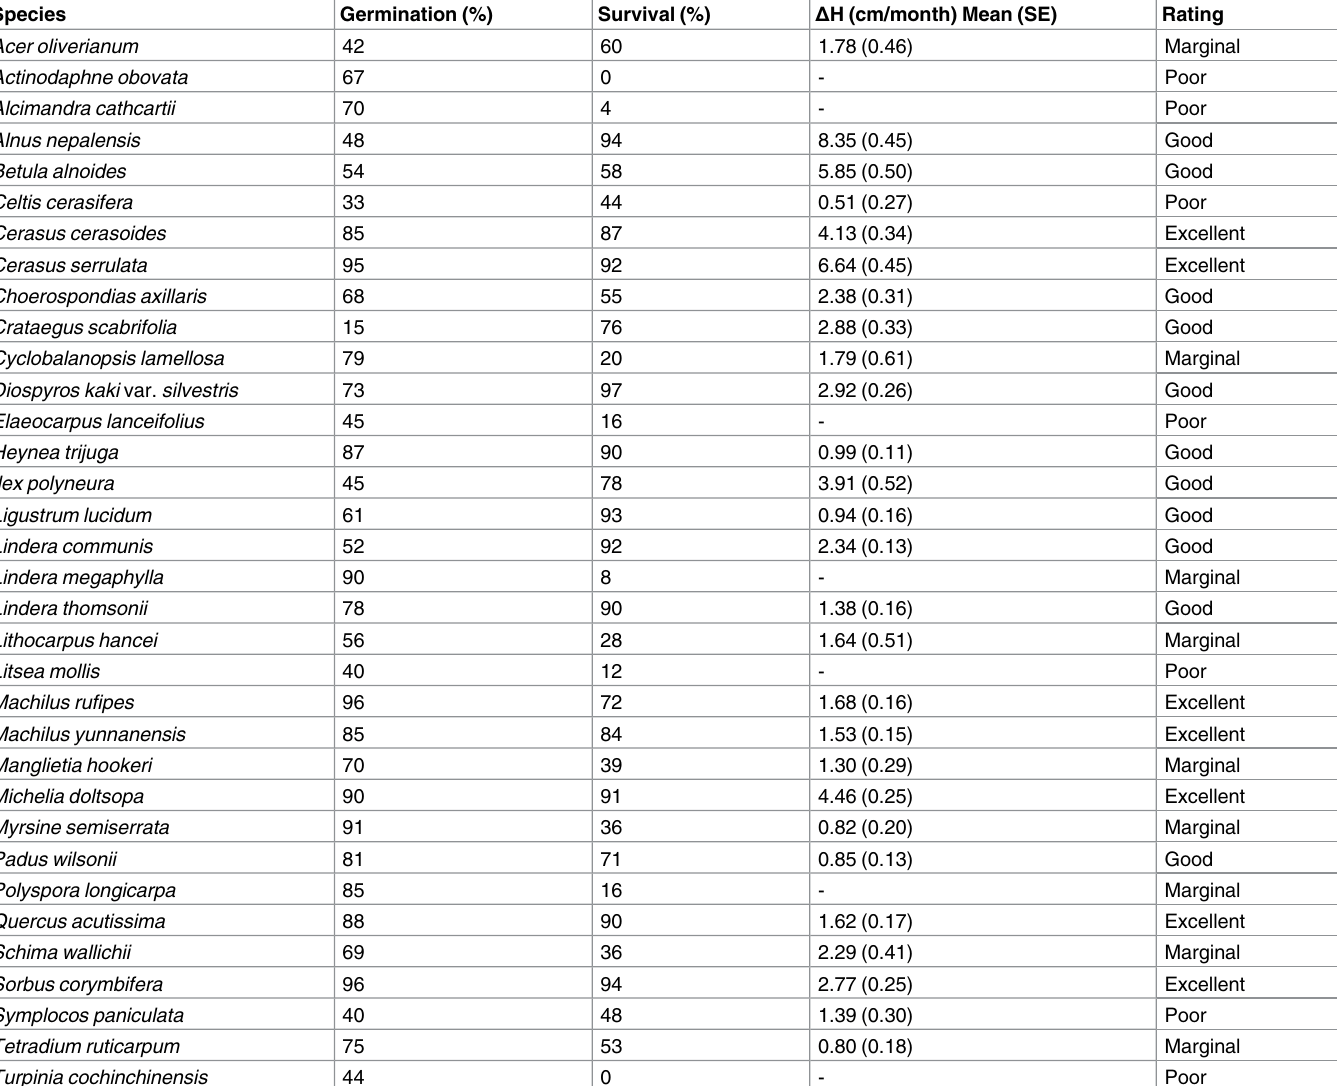
Table 3. Seed germination rates, seedling survival rates and growth performance of 34 native tree species from a subtropical evergreen broad- leaved forest in SW